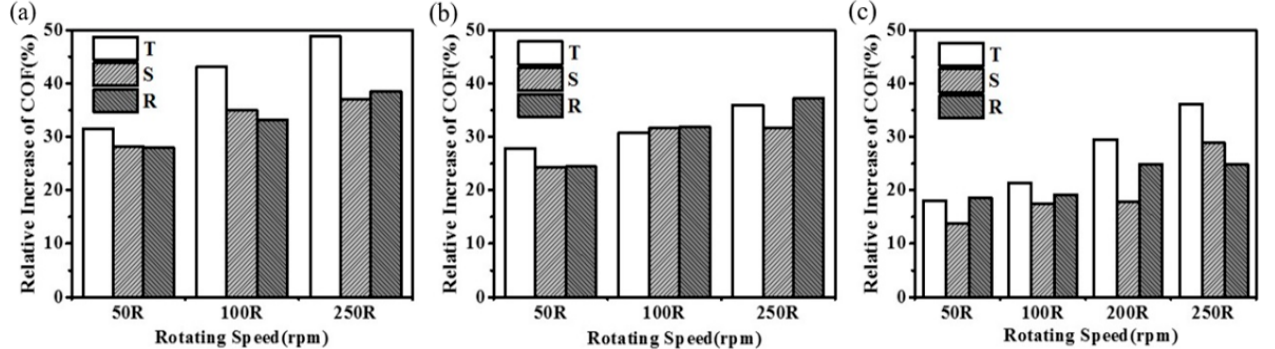
Figure 7. The influence of the other three textured specimens on the relative increases of COF compared with that of hexagon-textured specimens under different loads: ( a ) 20 N; ( b ) 50 N; ( a ) 70 N.